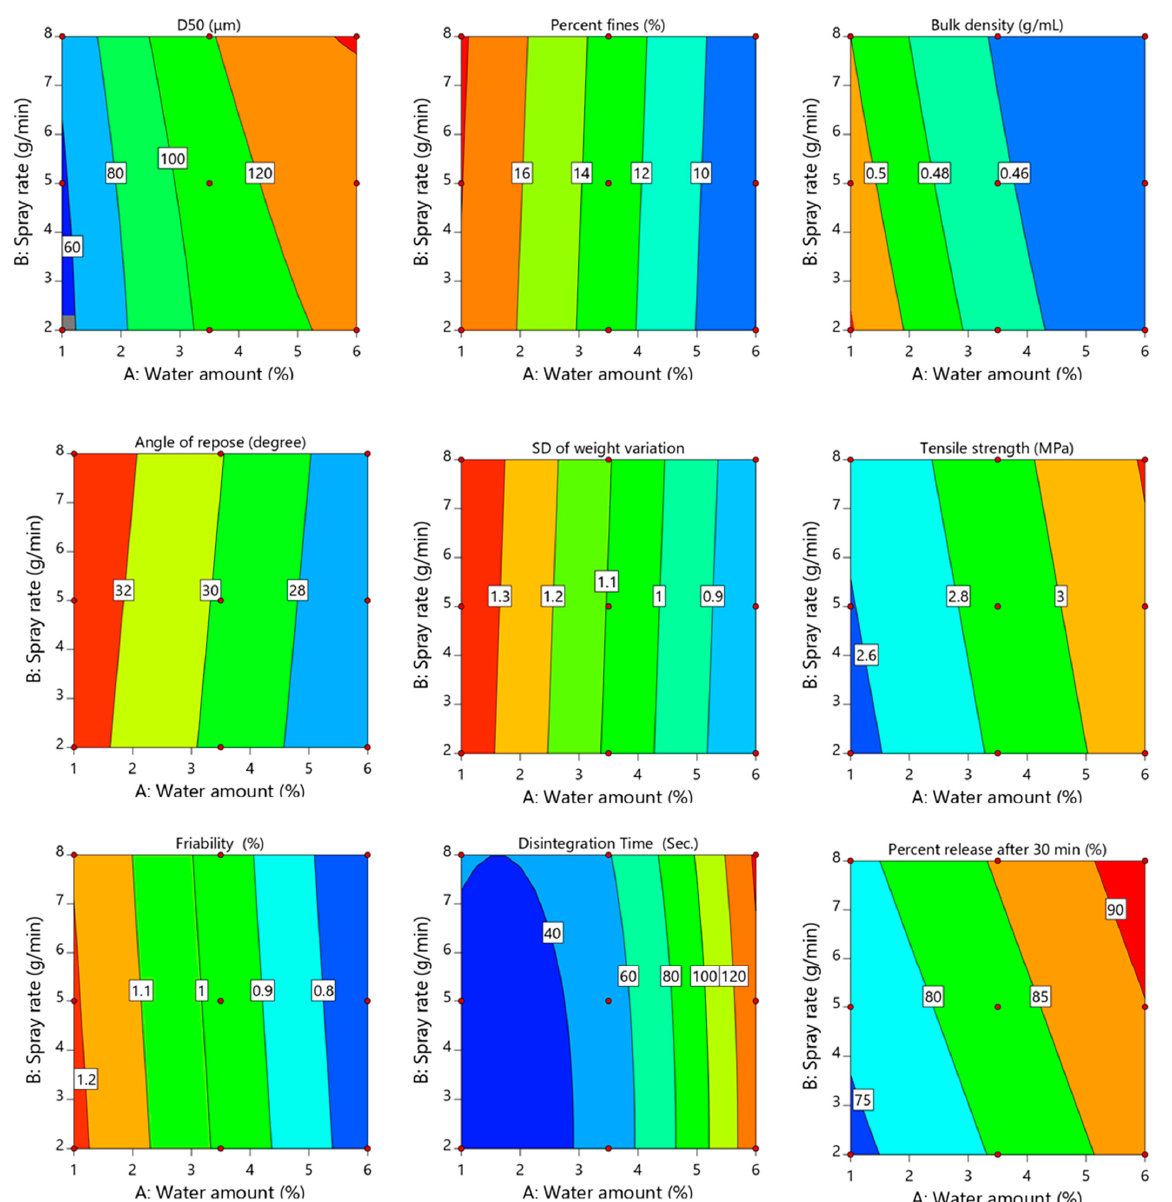
Figure 2. Contour plots showing the effect of water amount (X 1 ) and spray rate (X 2 ) on mean granule size (y 1 ), percent fines (y 2 ), bulk density (y 3 ), angle of repose (y 4 ), SD of weight variation (y 5 ), tensile strength (y 6 ), friability (y 7 ), disintegration time (y 8 ) and percent release after 30 min (y 9